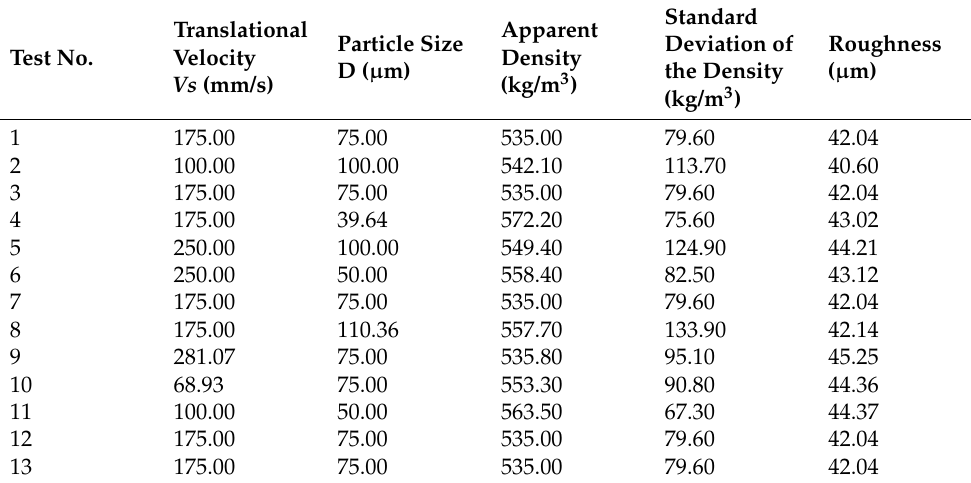
Table 4. DEM simulation test scheme and simulation results of powder laying process ( Rg = 20 mm, Vr / Vs =